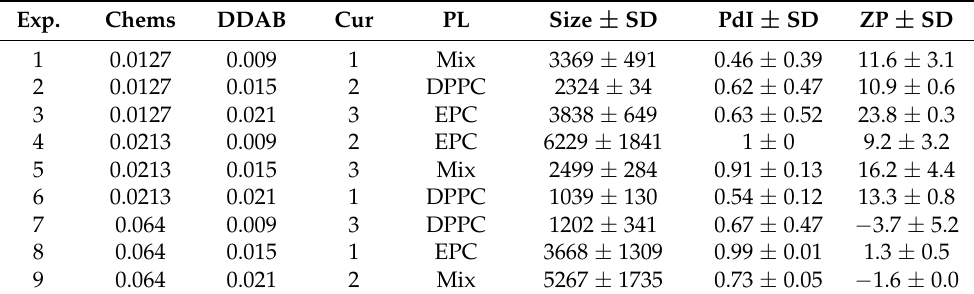
Table 2. Experimental matrix from L9 Taguchi array and results for size (nm), polydispersity index (PdI), and zeta potential (ZP, mV). Chems: cholesteryl hemisuccinate, Cur: curcumin,